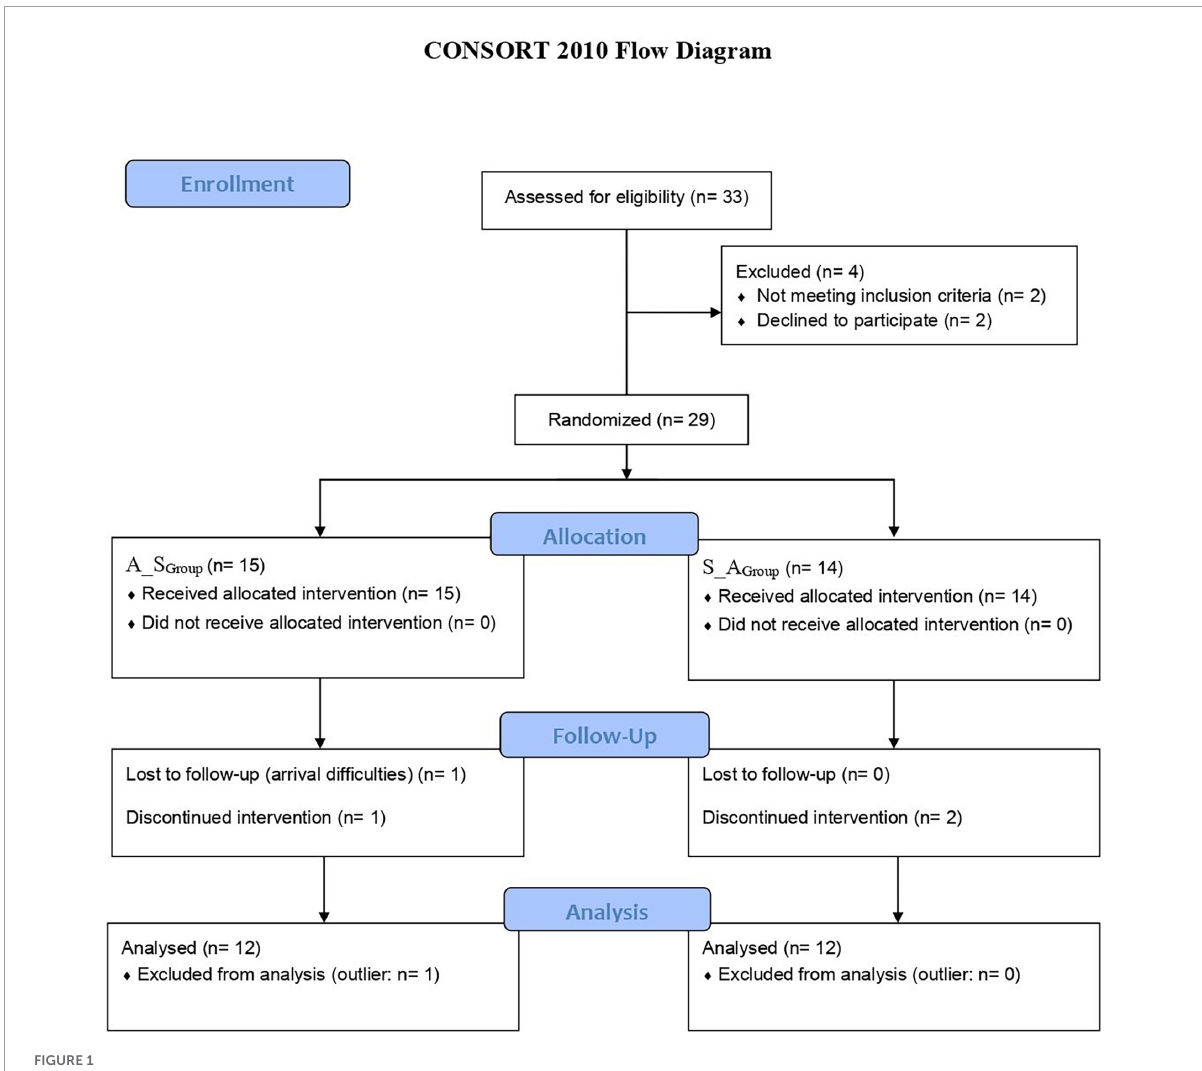
FIGURE1 CONSORT flow diagram of the